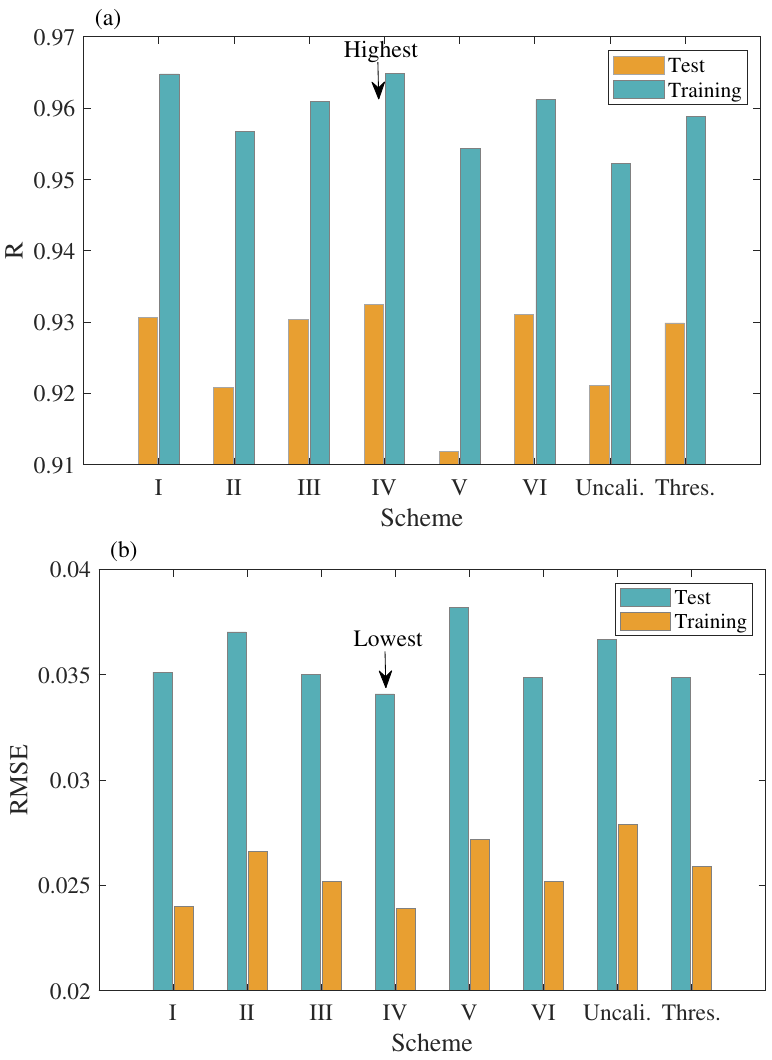
Figure 8. Statistics of SM retrievals: ( a ) R , and ( b )